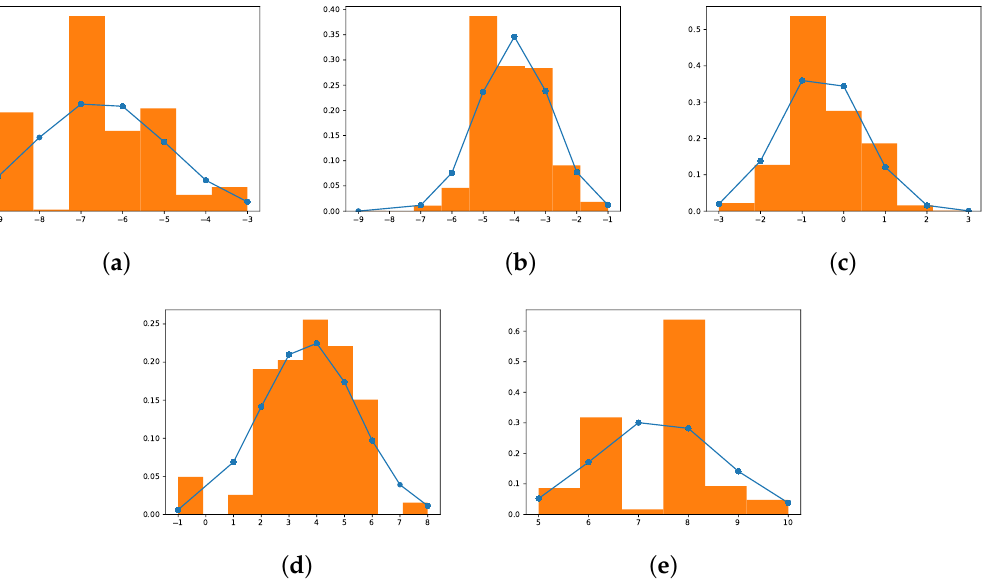
Figure 9. Error Distribution: ( a ) Expected = − 6; ( b ) Expected = − 3; ( c ) Expected = 0; ( d ) Expected = 3; ( e ) Expected =